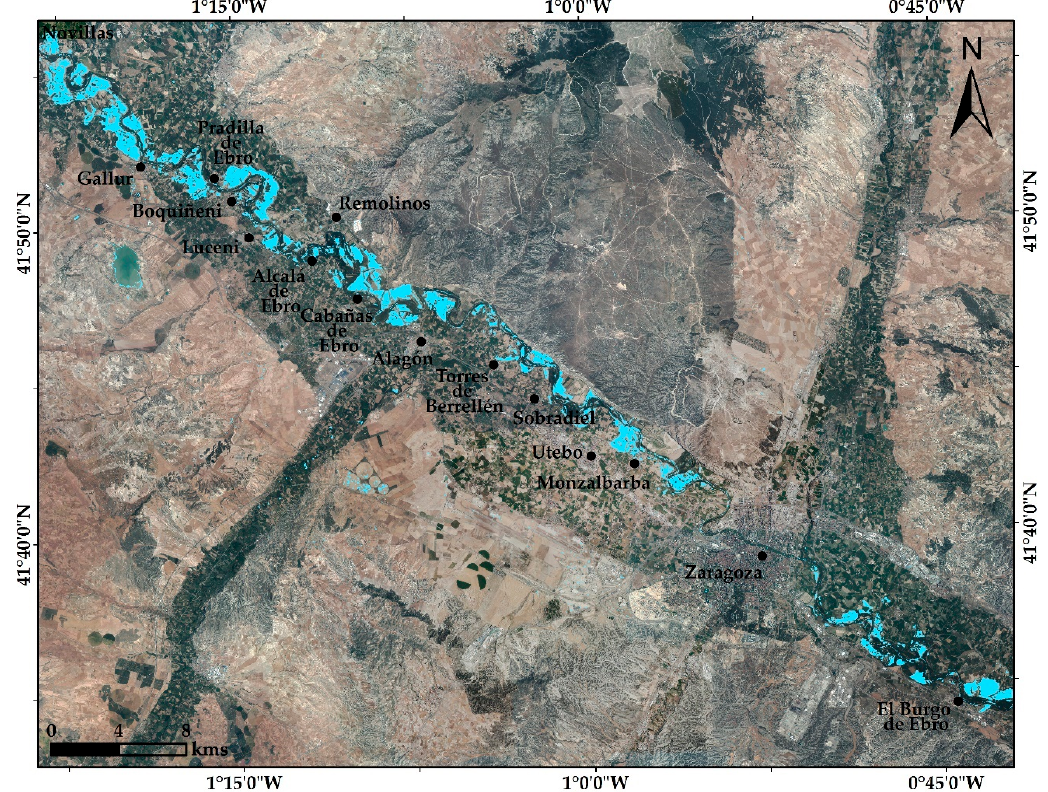
Figure 14. General flood map of the entire study area by calibration thresholds created from the RADAR image of 13 April 2018 and a scrubber with the permanently flooded water layer (Source: PNOA base map).